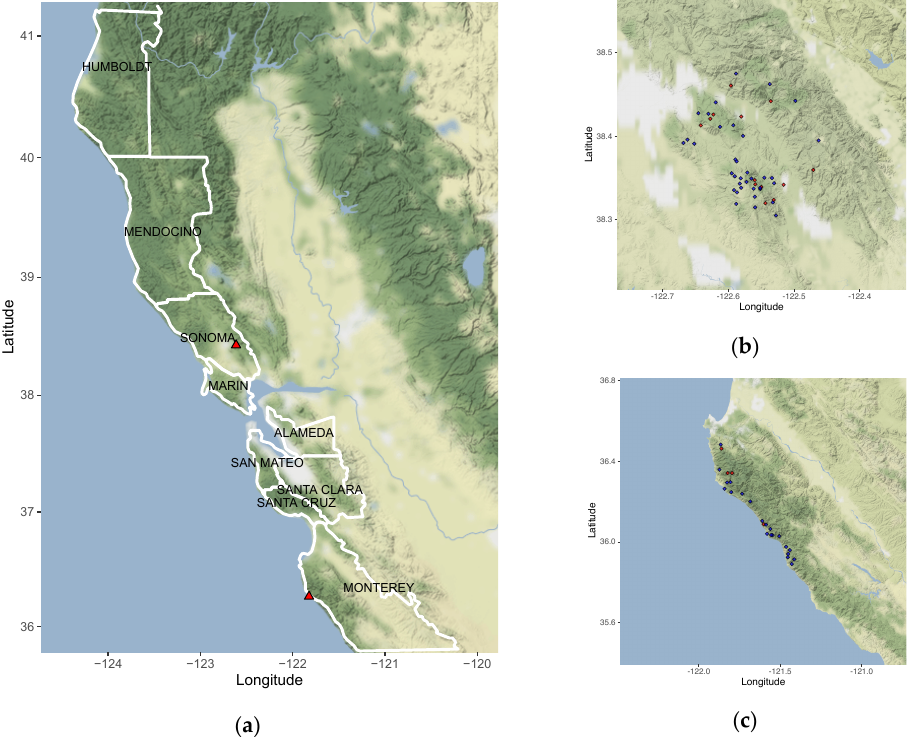
Figure 1. Maps of California counties where P. ramorum isolates were collected. Longitude and latitude are shown on the x- and y-axis. ( a ) Left panel shows the counties outlined in white where isolates used in the phylogeny (Figure 2, and Figure 4) were collected. Red triangles refer to Sonoma Co. and Monterey Co. which are zoomed in on the ( b ) top right and ( c ) bottom right panels. Red circles indicate plots where non-wild type (NWT) isolates were collected, and blue circles show where wild type (WT) isolates were collected. Isolates collected from ( b ) Sonoma Co. and ( c ) Monterey Co. plots where used in the environmental association study (Figure 6).